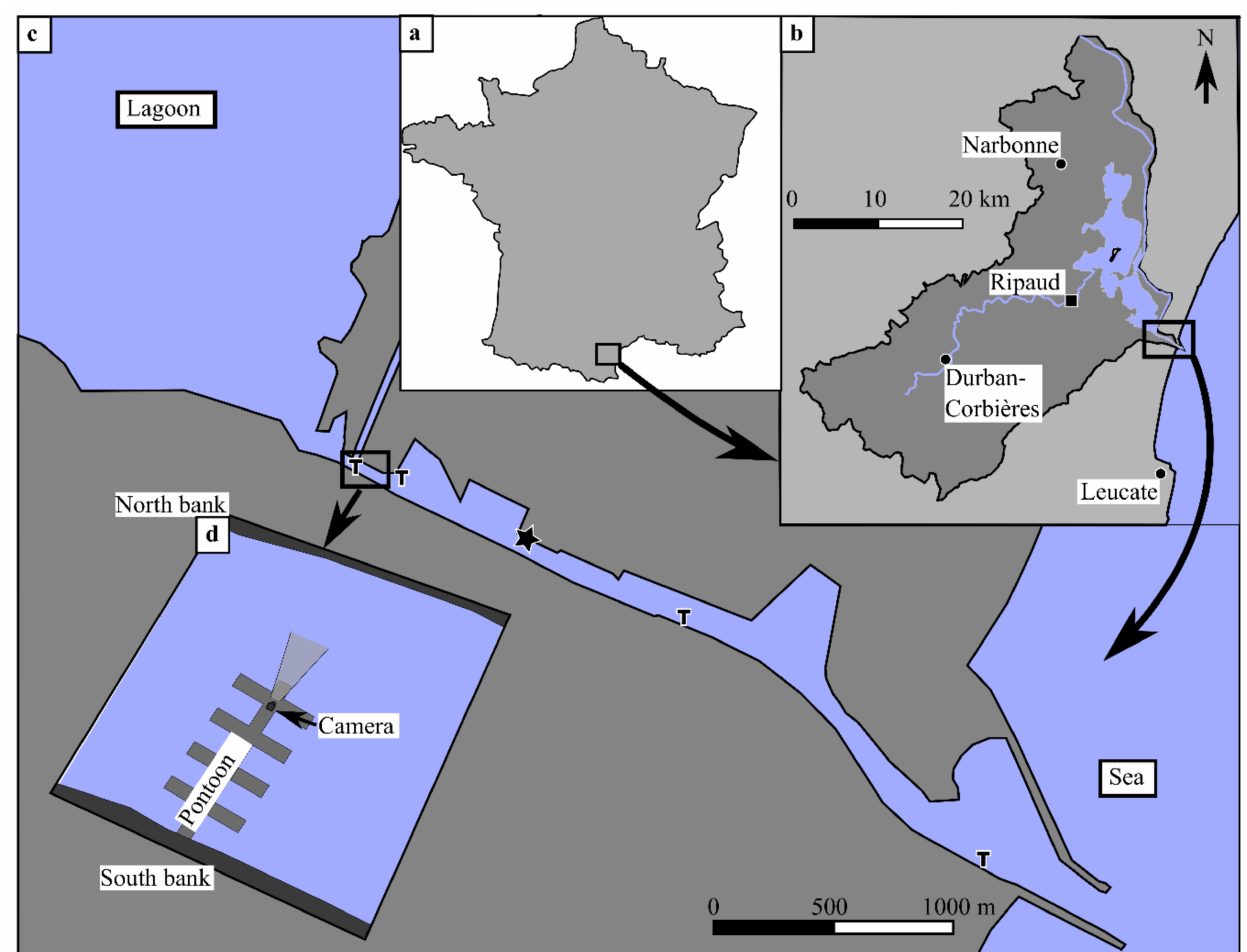
Figure 1. Location of the studied Bages-Sigean lagoon in southern France ( a ), the channel linking the lagoon with the sea ( b ) and the pontoon where the Adaptive Resolution Imaging Sonar (ARIS) camera was attached ( c – d ). The black circles represent the locations of the three meteorological monitoring stations and the black square indicates the location of the gauging station on the Berre river ( b ). The name of each station is specified on the map. The black star represents the location of the Horizontal Acoustic Doppler Current Profilers (H-ADCPs) and Conductivity–Temperature–Depth (CTD) probe and the black “T” marks the location of each temperature logger ( c ). The grey shaded area represents the estimated field of view of the camera in aerial view ( d